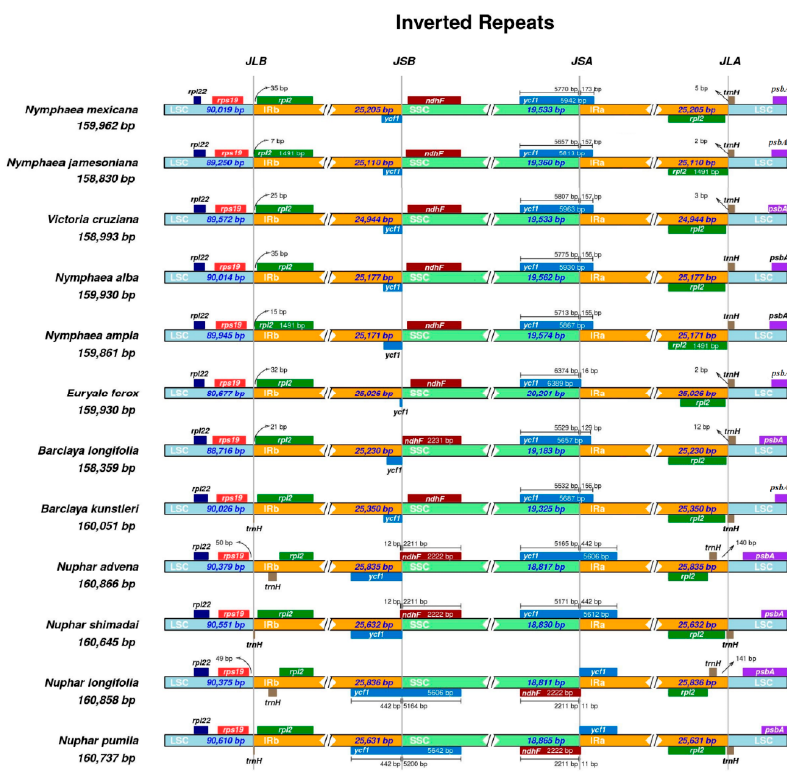
Figure 4. Comparison of the border positions of the large single copy, small single copy, and the inverted-repeat regions among chloroplast genomes of twelve species of Nymphaeaceae. Complete genes and portions of genes adjacent to the junctions are depicted by differently colored blocks.